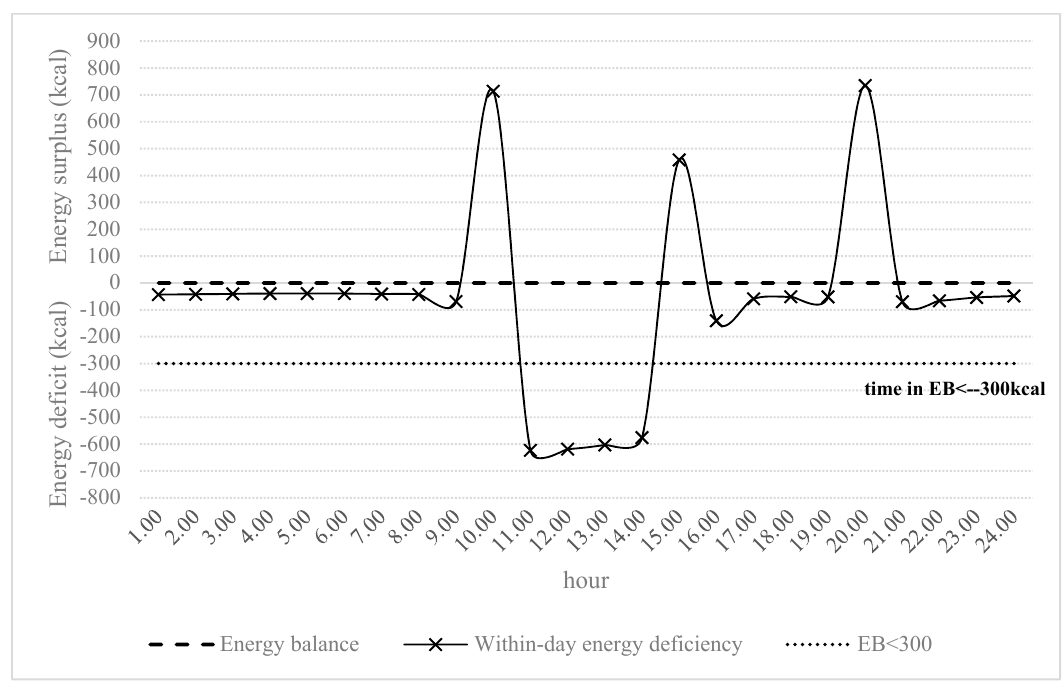
Figure 1. An example of how within-day energy availability (WDEB) neg and WDEB − 300 were calculated for one of the participants. The visual representation of the WDEB calculation of this figure is adapted from Fahrenholtz et al. [11].